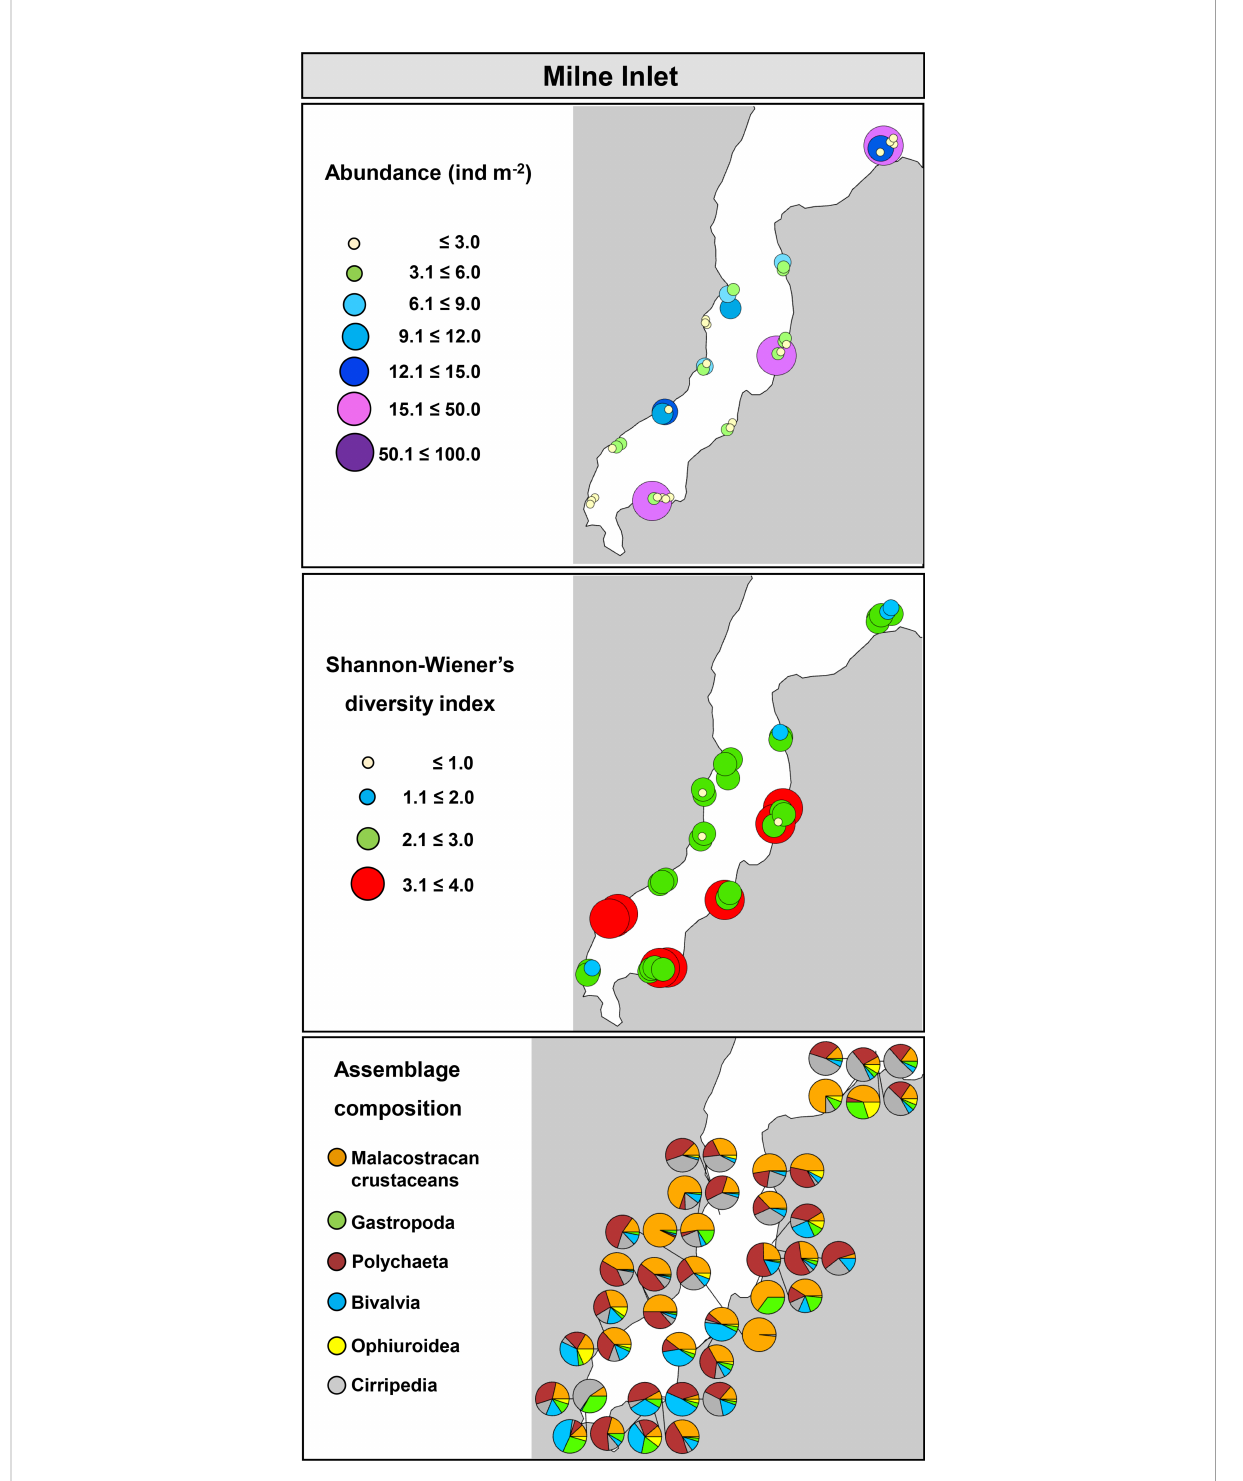
FIGURE 9 Community metrics and assemblage composition in Milne Inlet,